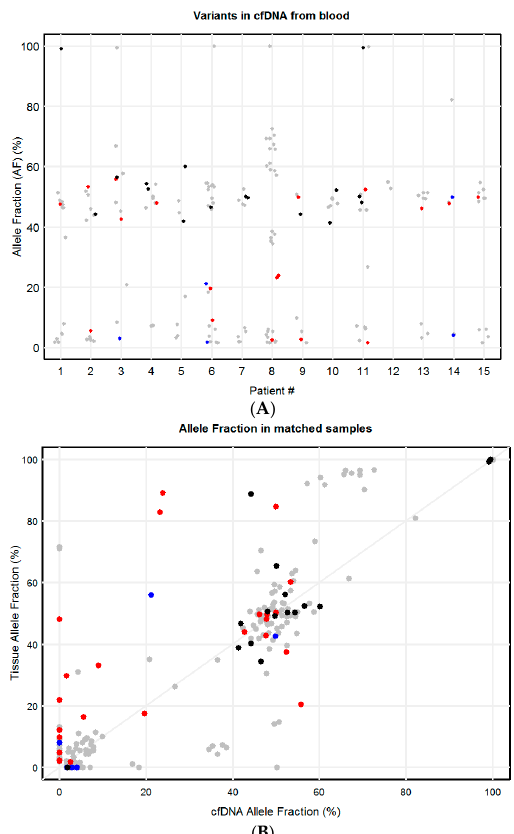
Figure 2. Allele fraction (AF) of genetic variants detected in blood cfDNA of 15 IBC patients with paired tissue samples in which blood and tissue were collected at the same time-point. Variants are shown for patients 1 to 15. ( A ) AF of variants detected using cfDNA from blood; ( B ) AF of variants detected in malignant tissue/cells and paired cfDNA from blood. In red, pathogenic variants; in blue, likely pathogenic variants; in black, variants of uncertain significance; in grey, benign or likely benign variants.